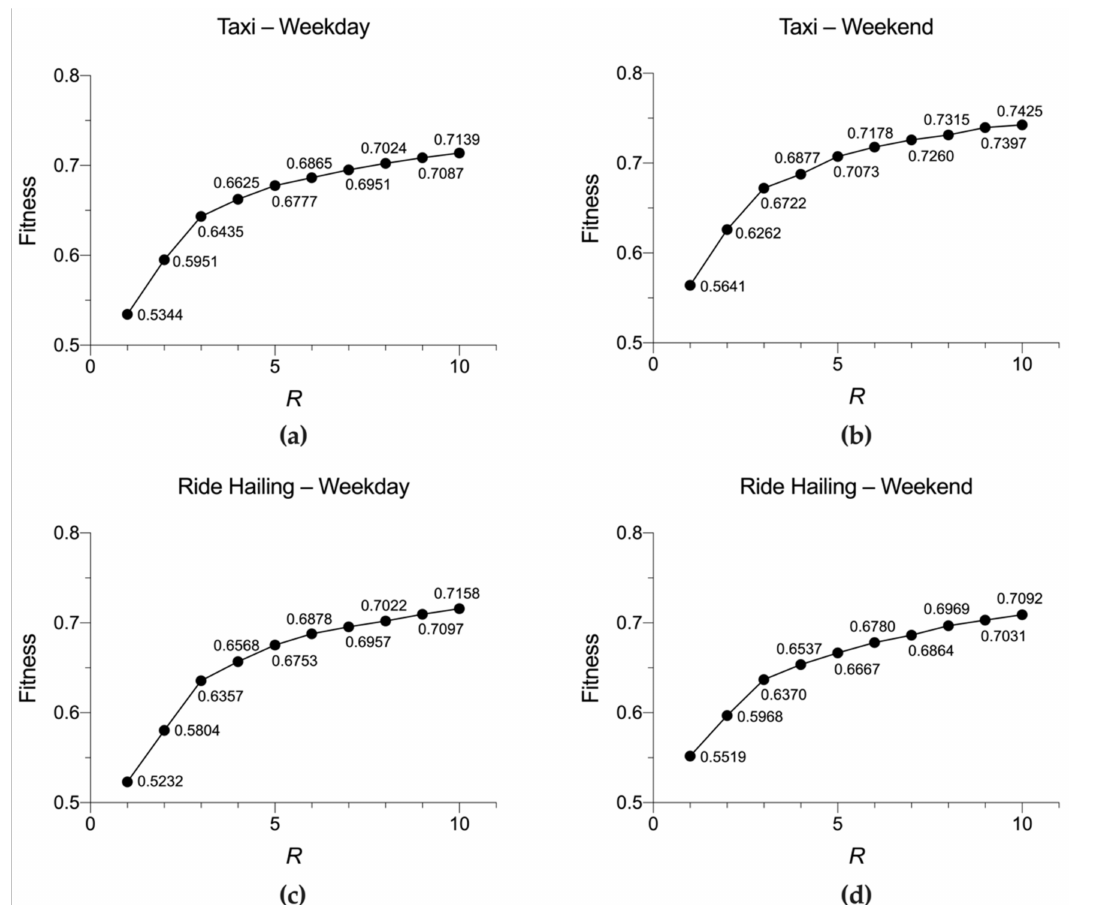
Figure 12. Fitness of tensor factorization by different R settings in each